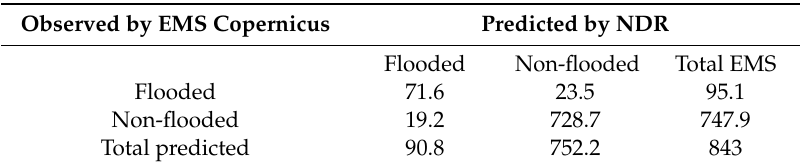
Table 4. Confusion matrix. Data in square kilometers 1 .